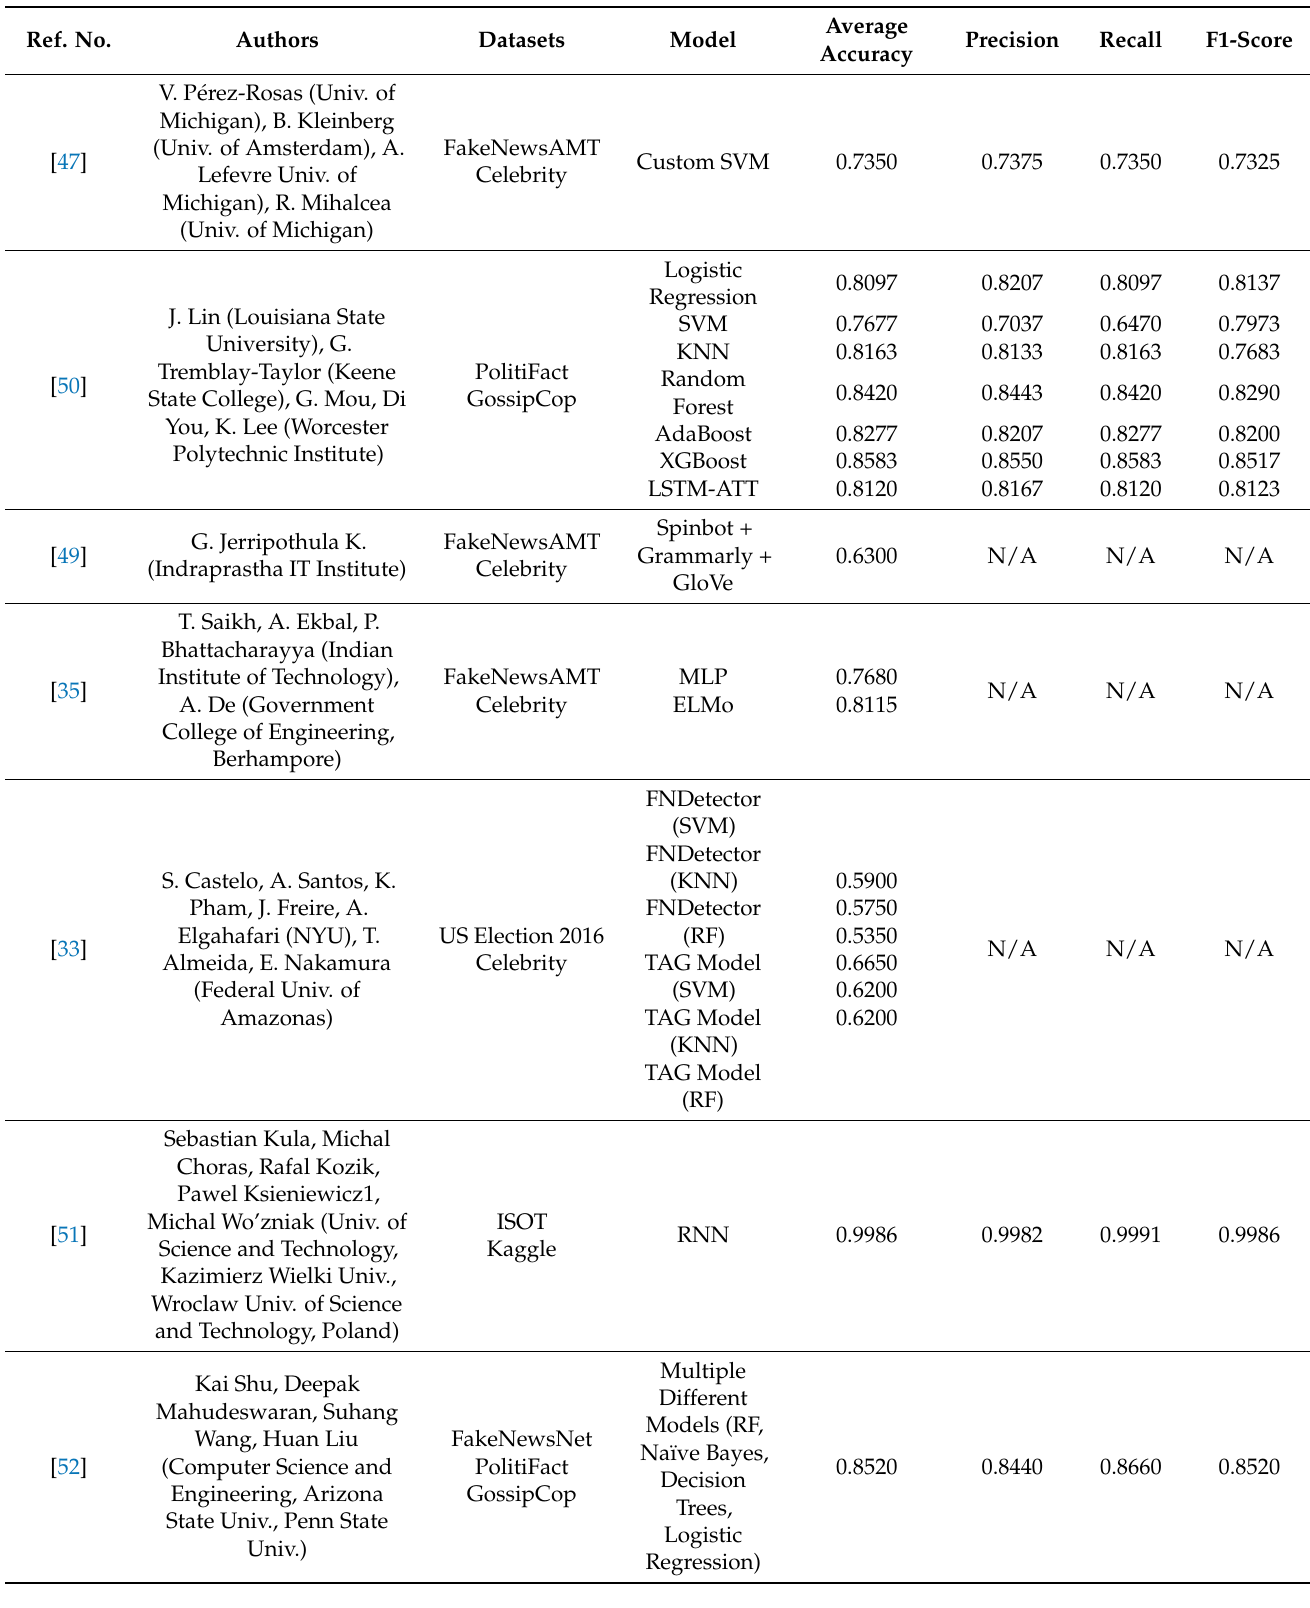
Table 4. Performance Evaluation of Cross-Domain